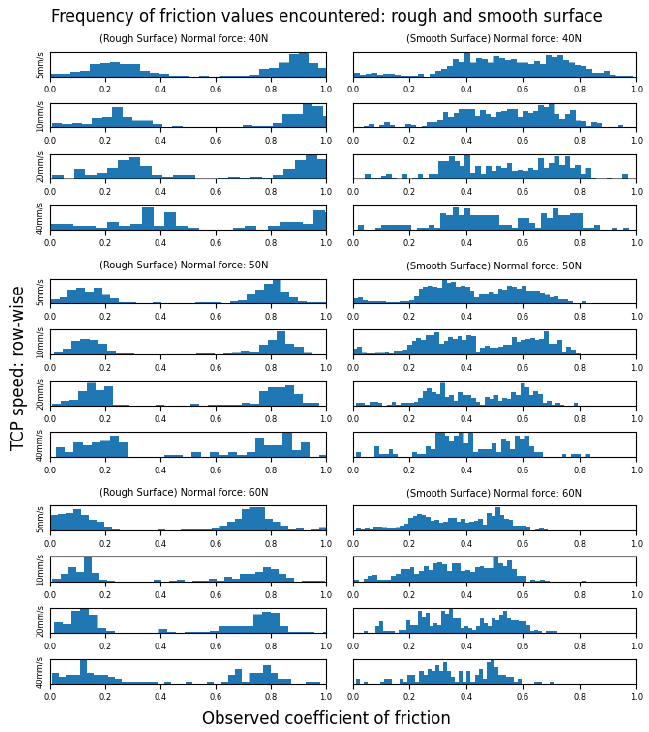
Figure 9. Histogram plot for two different raster paths over two plates of different roughness values. Results for rough and smooth CFRP surfaces show the effects of speed and applied force on the frequency of the observed friction values as a percentage of the total number of